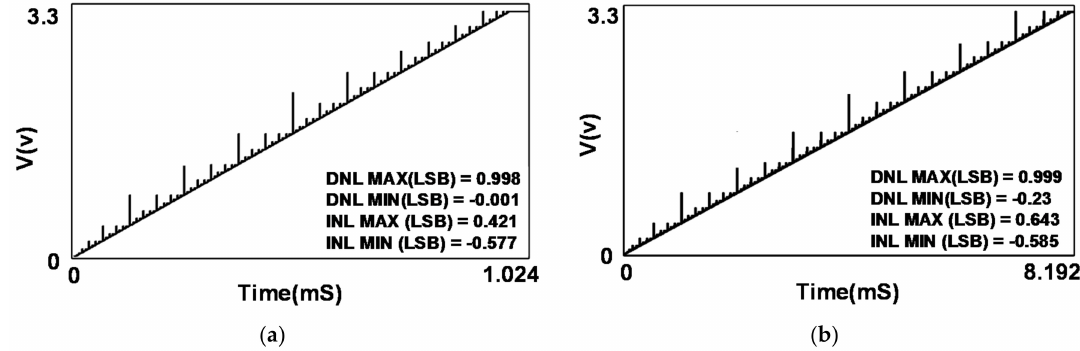
Figure 17. Ramp simulation for ( a ) 10-bit operation mode and ( b ) 12-bit operation